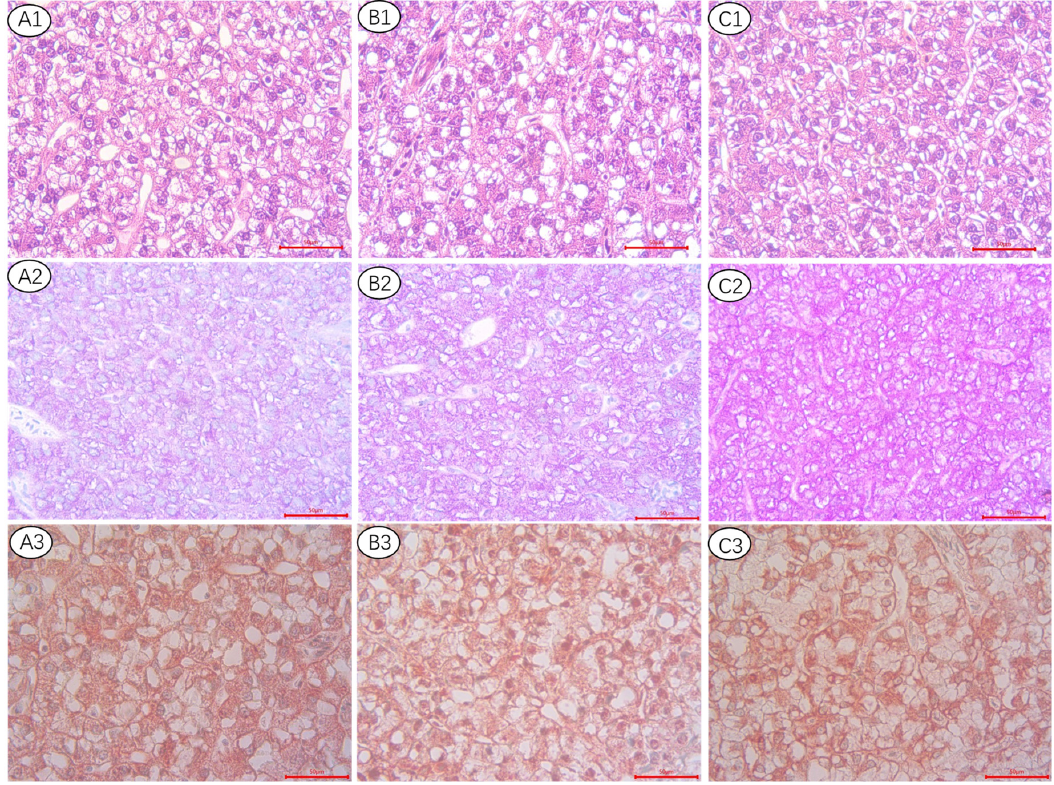
Figure 1. Histological appearance of liver from triploid rainbow trout fed the 20% lipid content ( A1– A3 ), 25% lipid content ( B1 –B 3 ), and 30% lipid content ( C1–C3 ) diet, respectively. Hematoxylin-eosin (HE) staining: ( A1 – C1 ). Magnification × 400. Periodic acid-Schiff (PAS) staining: ( A2 – C2 ), Magnification × 400. Oil red staining: ( A3 – C3 ), Magnification × 400.